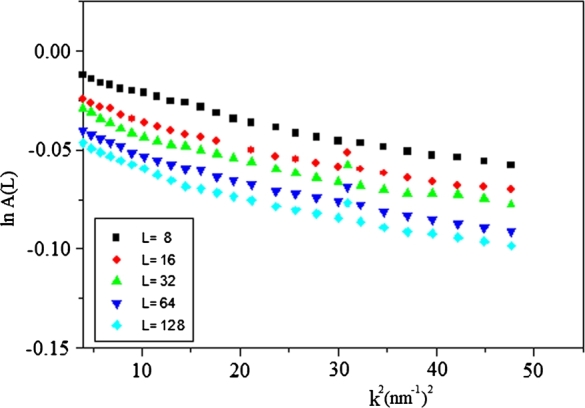
The relation between lnAL and k2 for VBM crystal, according to classical Warren-Averbach equation.